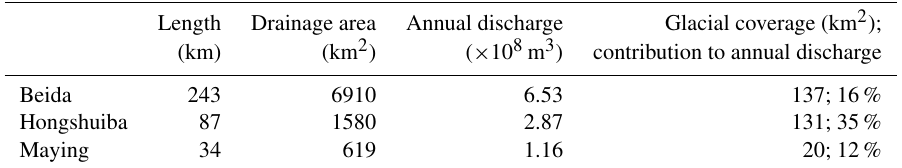
Figure 1. (a) Digital elevation map of the Hei He drainage system. Active glacial coverage map based on Raup et al. (2007). Inset figure: location with respect to monsoon and westerly moisture sources. (b–d) River and maximum elevation profiles of three major tributaries of the Hei He drainage, extracted from 30m SRTM. Maximum elevation sampled from swaths 16km in width, centered on each river. Locations of active strands of the North Qilian fault denote foreland-hinterland junction at mountain front. All three rivers exhibit deep incision below the top of foreland-basin sediments. Red highlights knickzone reach within bedrock. Dashed line in (d) is reconstructed profile of the Beida River from the ca. ∼ 24ka T1 terrace tread, prior to onset of rapid incision phase. Table 1. Hydrological information of the three major rivers draining the western North Qilian Shan (Gansu Province Local Chronicles Compilation Committee,